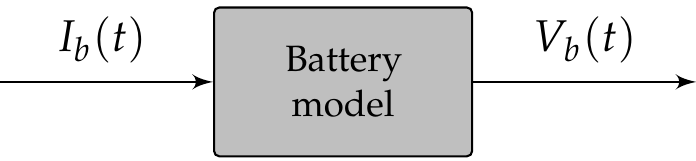
Figure 1. An abstract representation of the desired